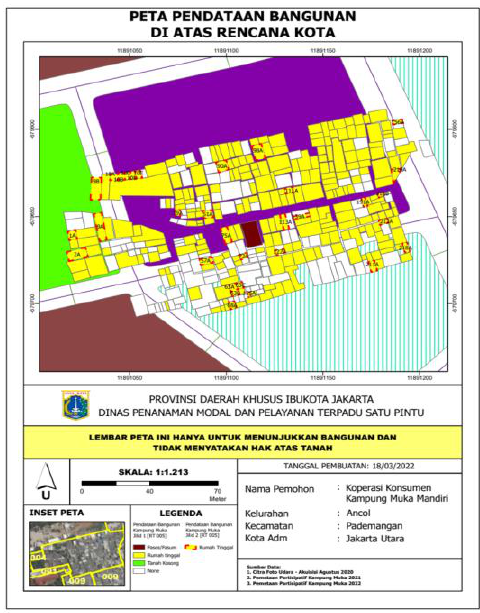
Figure 11 . Building map of Priority Villages program